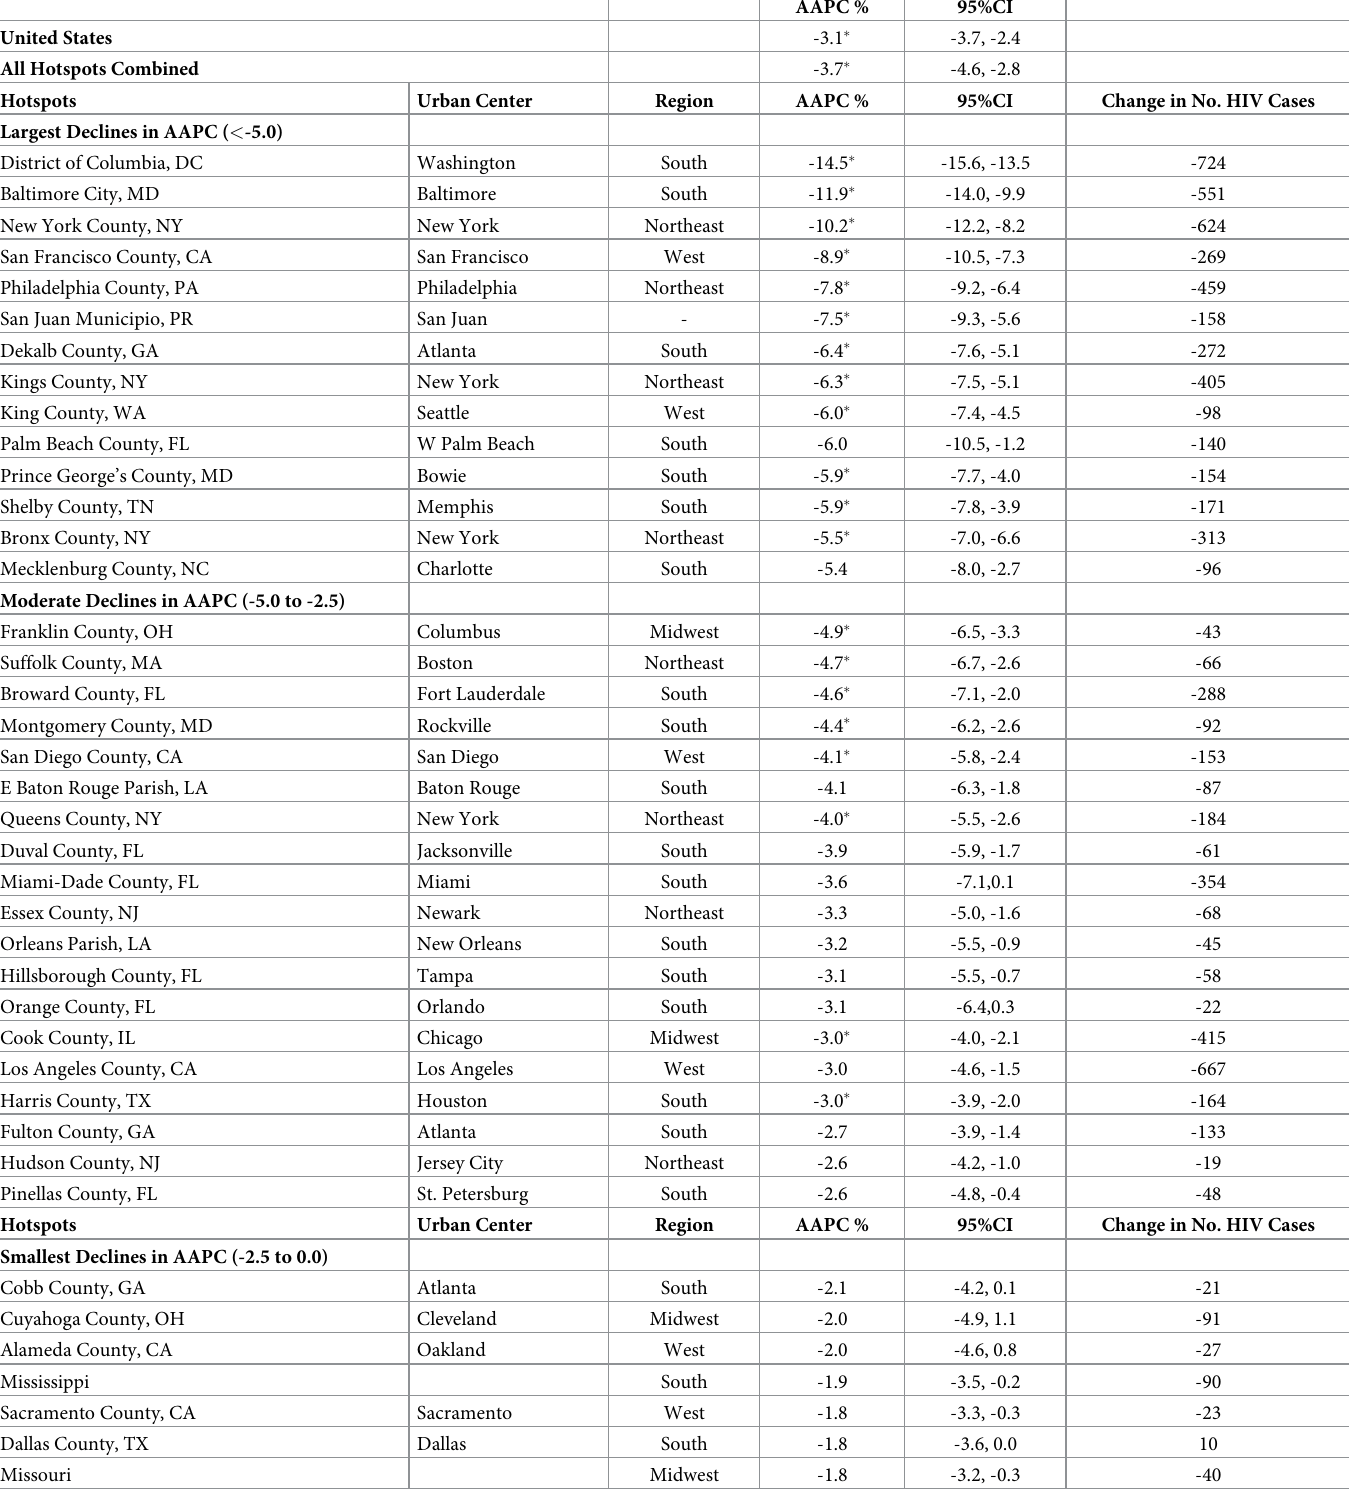
Table 1. Average annual percent change (AAPC) and change in number of newly diagnosed HIV cases in US hotspots, 2008–2017.